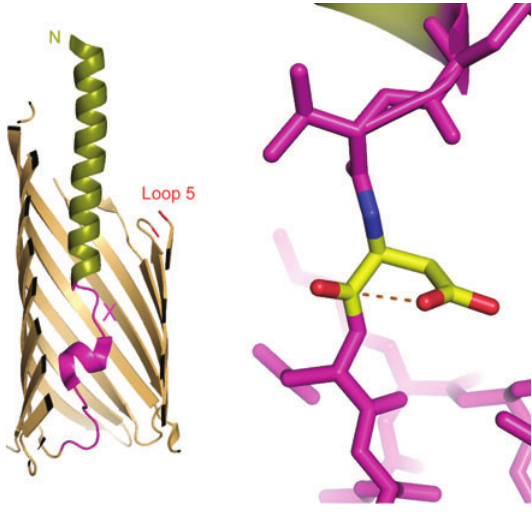
Figure 7 The self-cleavage mechanism of SPATEs. A cartoon representation of the barrel domain of Hbp, connected to the C-terminal residues of the passenger domain. This crystal struc- ture (PDB 3AEH) was solved by replacing the essential asparagine residue (N1100) of the cleavage site with aspartic acid (59) . The cleavage site (shown by a cross in the left panel) is found between two α -helices inside the barrel lumen. A close-up view is shown on the right. Attack by the side chain on the main-chain carbon atom is indicated by the orange dotted line.